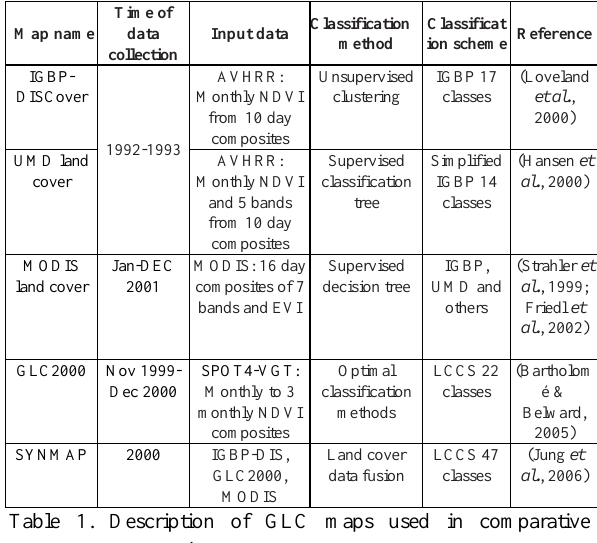
Table 1. Description of GLC maps used in comparative